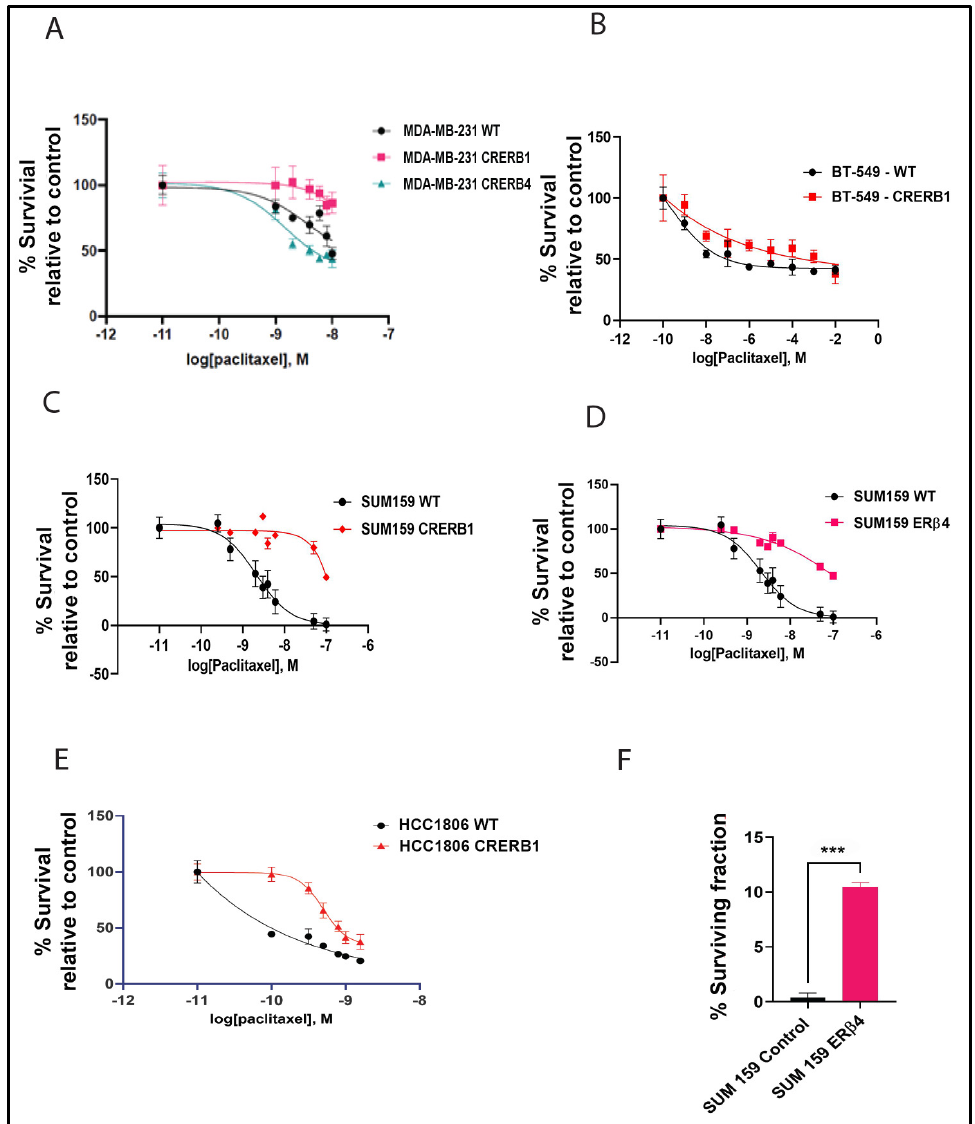
Figure 2. Chemotherapy treatment of TNBC cell lines shows opposing effect of ER β 1 and ER β 4. ( A ). MTS assay comparing Log dose response curves for Paclitaxel in MDA-MB-231 WT, CRERB1 and CRERB4. ( B ). Log dose response curves for paclitaxel in BT549 WT compared to CRERB1 ( C ). Log dose response curves for paclitaxel in SUM159 WT compared to CRERB1. ( D ). Log dose response curves for paclitaxel in SUM159 WT compared to ER β 4 expressing cells. ( E ). Log dose response curves for paclitaxel in HCC1806 WT compared to CRERB1. ( F ). SUM159 and SUM159 ER β 4 cells were seeded at 500 cells/well in triplicate, and treated with paclitaxel for 48 h. Colonies were then allowed to grow in regular media for 12 days. The surviving fraction was calculated after normalizing for plating efficiency. Two-tailed Student’s t -test was used *** p <